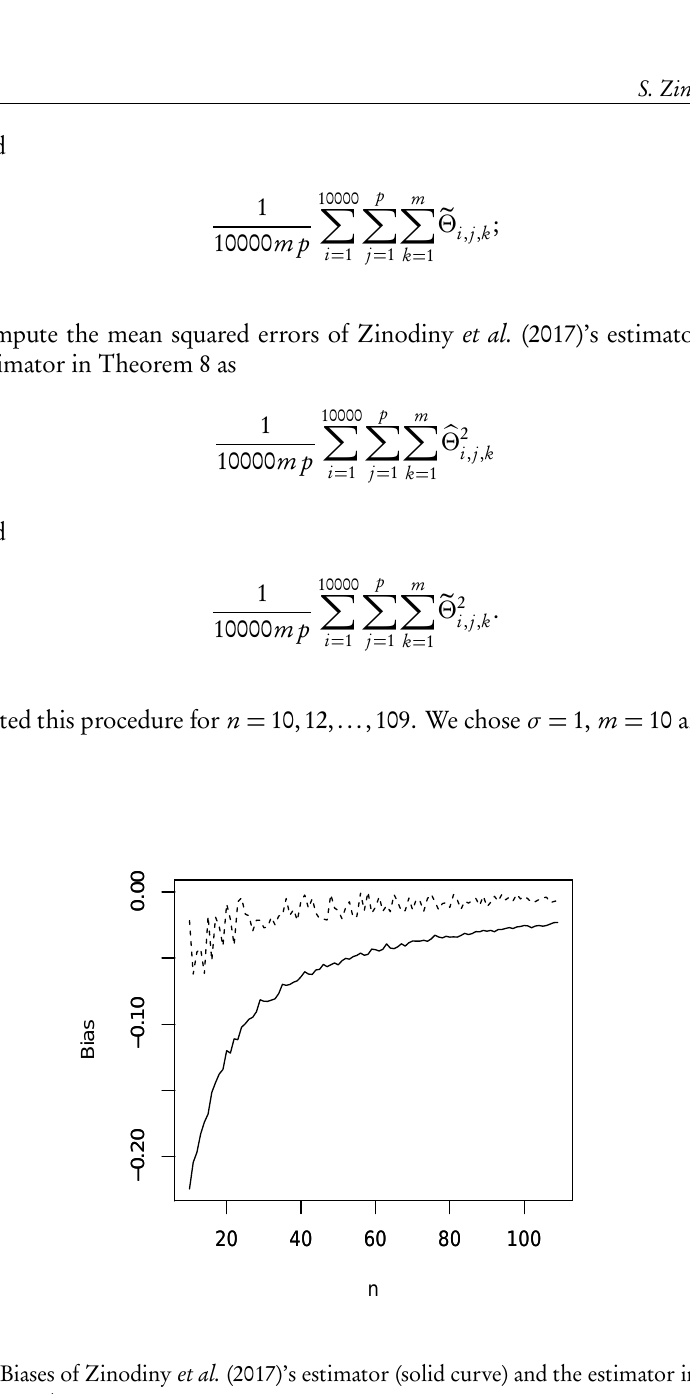
Figure 1 – Biases of Zinodiny et al. (2017)’s estimator (solid curve) and the estimator in Theorem 8 (broken curve) versus n